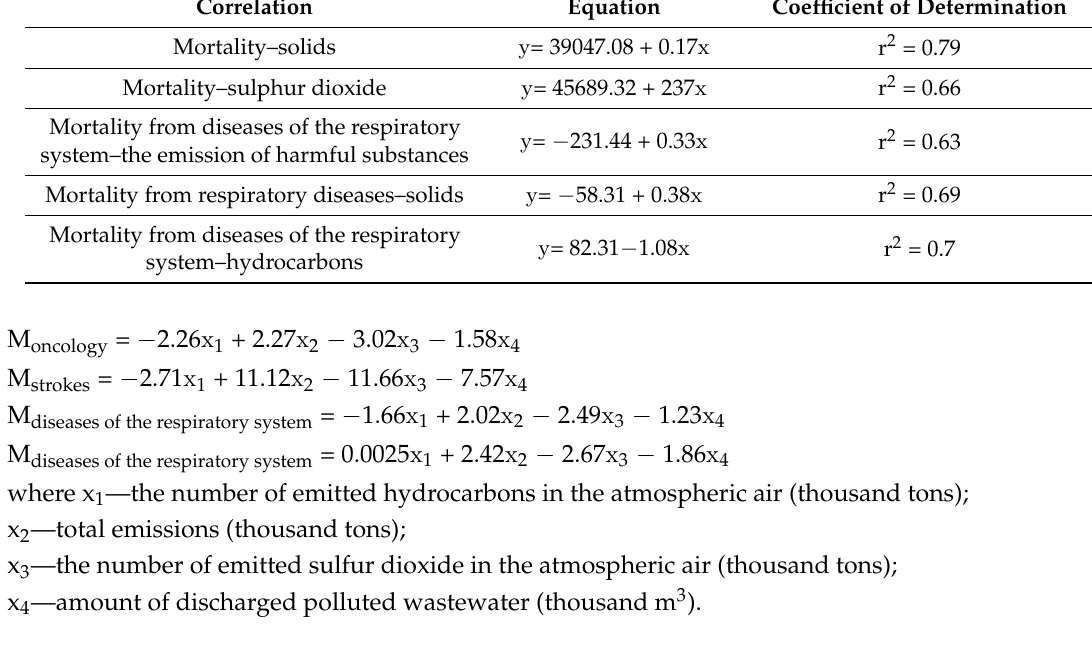
Table 2. Dependence of mortality on emissions of harmful